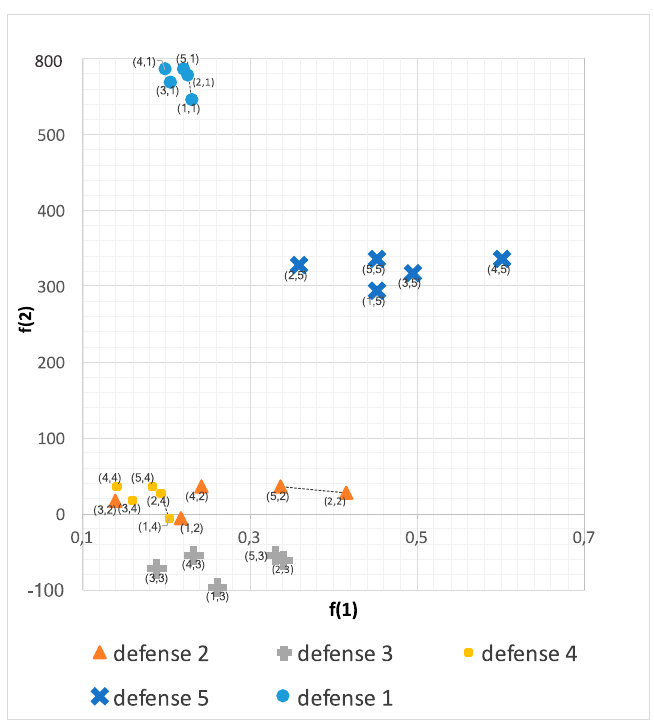
Figure 9. Target space in defender’s view.